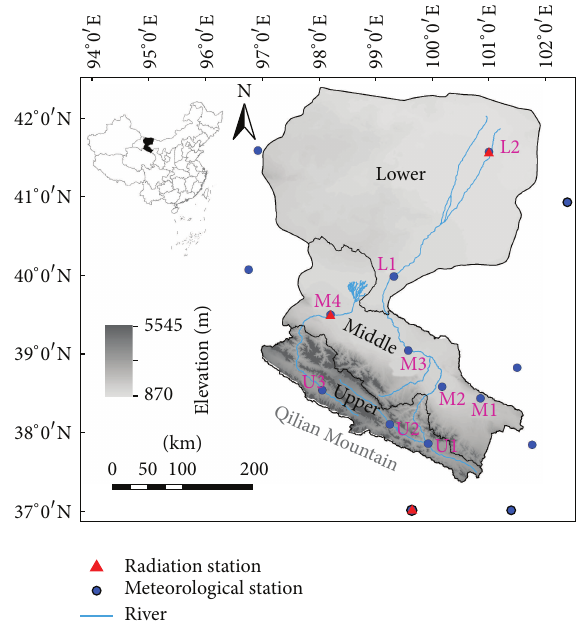
Figure 1: Location of the HRB and spatial distribution of the meteorological and radiation stations. U, M, and L represent the upper, middle, and lower regions in the basin,